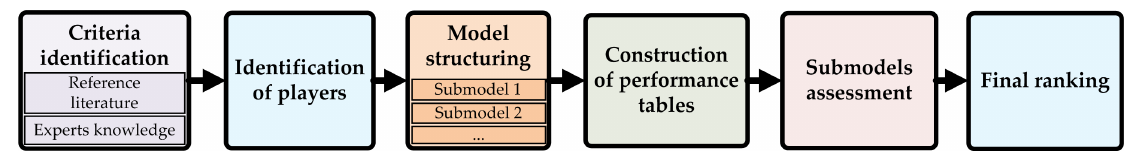
Figure 2. Research